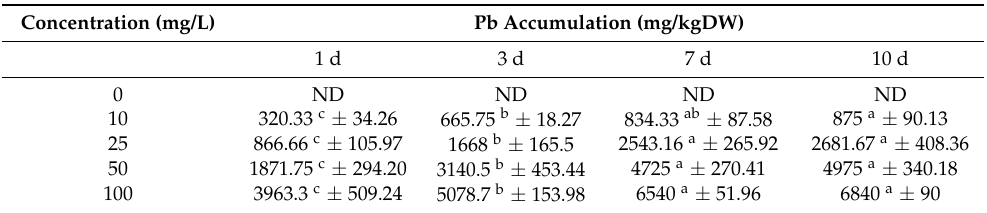
Table 3. Lead accumulation in Ludwigia stolonifera treated with different concentration of lead for different exposure times.